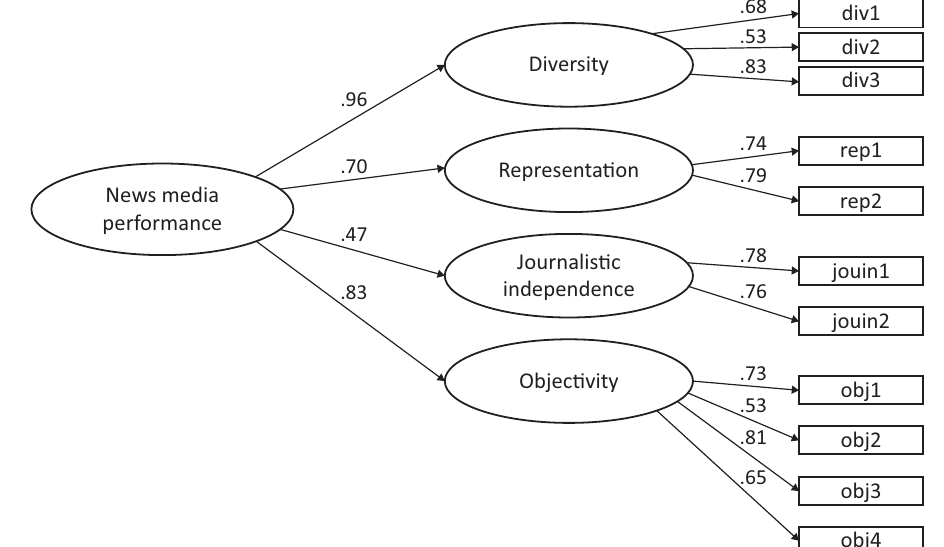
Figure 1. Confirmatory factor analysis with indicators for perceived news media performance. and the respective construct they are supposed to mea- sure (diversity, objectivity, journalistic independence, and representation). Due to the large sample size, multi- group confirmatory factor analysis is likely to overesti- mate differences between constraint and unconstraint models (Davidov, 2009). Thus, we relied on Chen’s (2007) recommendation to compare RMSEA and CFI between models. An indication of lack of invariance can be de- tected when the RMSEA rises more than .015 units and the CFI exceeds .010 when comparing between con- straint and unconstrained models (Chen, 2007). With a Δ RMSEA = − .007 and a Δ CFI = .000, our model demon- strates metric invariance (see Table 2).